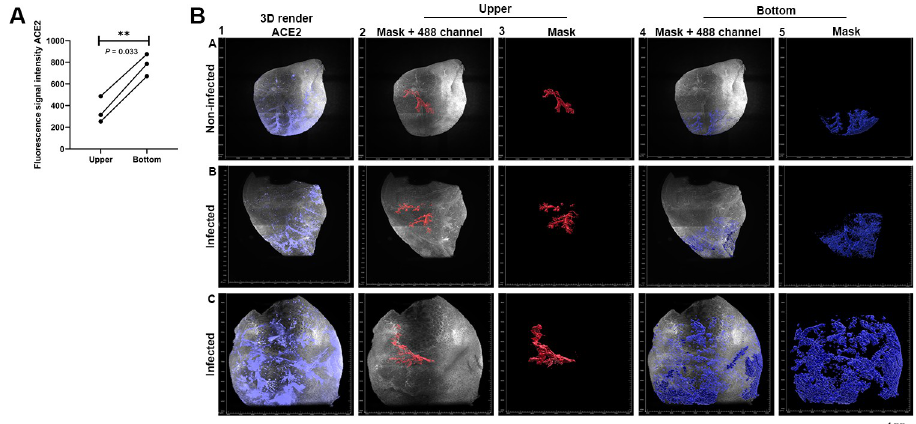
Fig 6. ACE2 is differentially expressed in (non-)infected Syrian hamster lung lobes. ACE2 signal shown in purple with autofluorescence (488 channel) in grey. The selected regions “upper” in red and “bottom” in blue. (A) Signals of “upper” and “bottom” were quantified, with significant differences in intensity between these regions (P = 0.033). (B) In panel A-C 1 3D render of ACE2 channel shown, hereafter a mask for the “upper” was generated, shown with and without the 488 channel (gray) in panel panel A-C 2–3. Masks for the “bottom” regions was also generated with and without the 488 channel in panel A-C 4–5. Selected regions were generated with the “Seed Points Diameter” tool in Imaris 9.7, after which all values were averaged for grouped analysis to assess the statistical